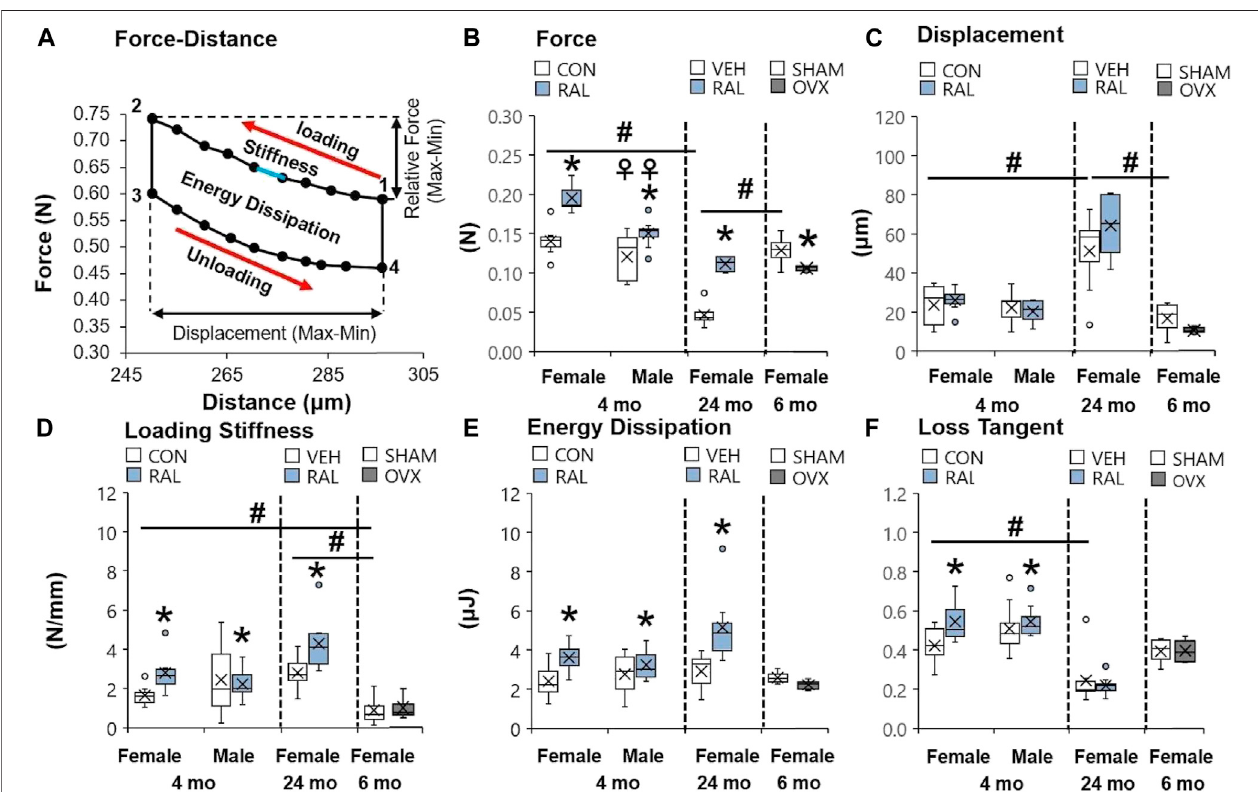
FIGURE 3 | Raloxifene reversed the loss of strength and viscoelasticity in the IVD engendered by aging and biological sex. (A) Diagram of a single cycle of force – distance compressive loading of an IVD beginning at point 1 and ending at point 4. Mechanical properties included (B) relative force (2 minus 1 in y-axis), (C) displacement (2 minus 1 in x-axis), (D) loading stiffness (slope between 1 and 2), (E) energy dissipation (area inside the loops 1 through 4), and (F) loss tangent (phase shift between force and displacement curve). Data are represented as box plots with mean marked as cross (x), 25/75% deviation lines, and maximum/minimum whiskers. *: Control (CON, n = 5/sex/group) vs. raloxifene (RAL), SHAM ( n = 4 – 5/group) vs. ovariectomized (OVX), vehicle (VEH, n = 8/group) vs. RAL; # : aging effect (4 months vs. 6 months vs. 24 months); \ : sex effect (male vs. female), p < 0.05.